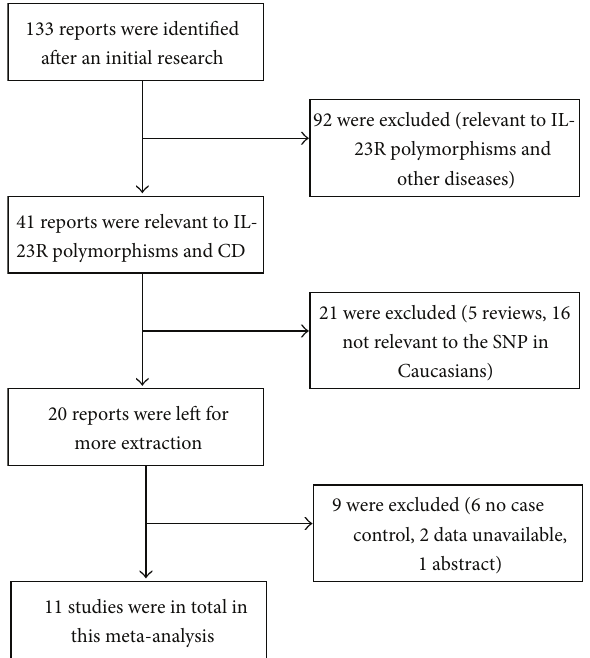
Figure 1: Flow diagram of the study selection process and specific reasons for